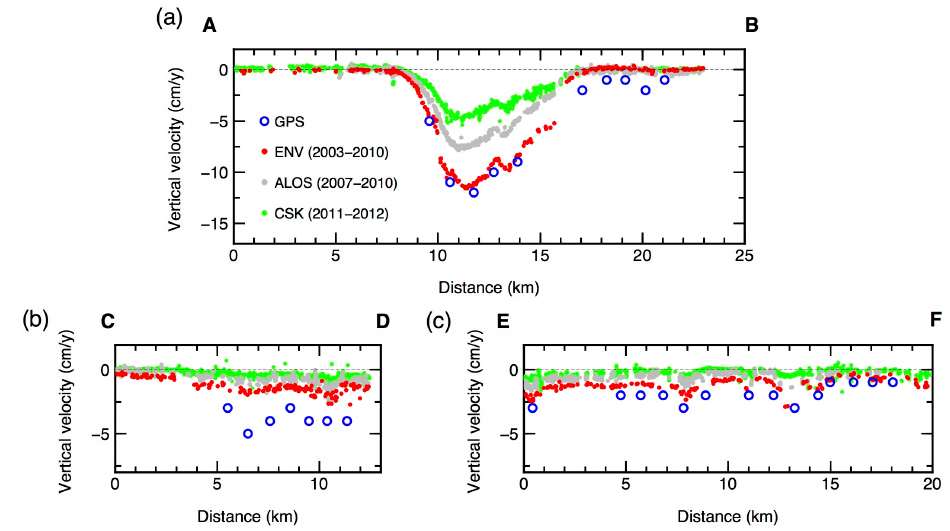
Figure 8. Cross-sections showing ground deformation rates from ENVISAT data (red dots), ALOS data (gray dots), COSMO-SkyMed (CSK) data (green dots) and GPS measurements (blue circles). The temporal interval of each InSAR dataset is indicated in ( a ). GPS velocities were obtained by comparing the reference vertical positions provided by the IGNE, which varies in the network between August–September 2004 and March 2009 (see Figure 1b), and the new vertical positions measured in 2013. The location of the cross-sections is indicated in Figure 2a: ( a ) shows ground deformation rates across A–B, ( b ) shows ground deformation rates across C–D and ( c ) shows ground deformation rates across E-F.